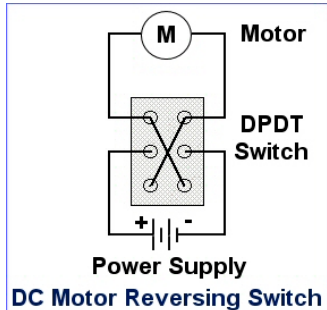
Figure 10. Circuit for DC motor with double pole double throw (DPDT) switch and power connector.